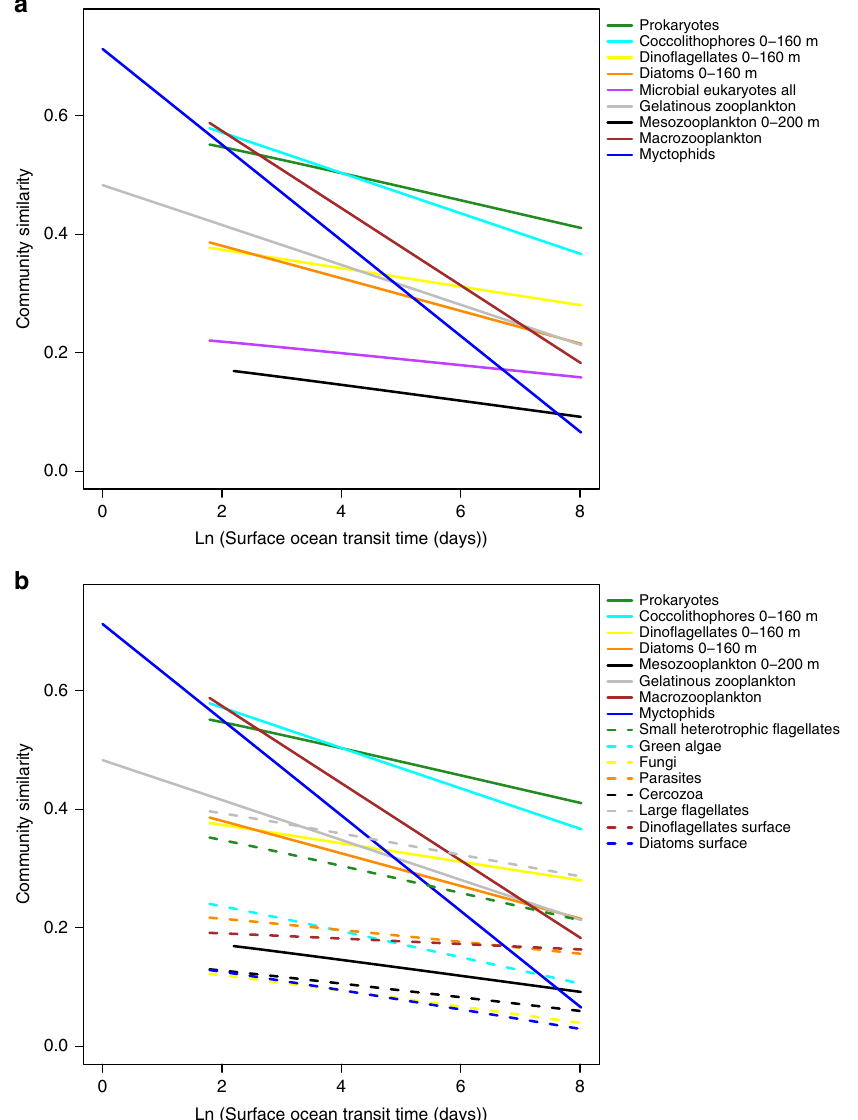
Fig. 1 Time-decay between community similarity and surface ocean transit time. Time-decay relationship between community similarity using Jaccard similarity index and surface ocean transit time. Each line represents the community similarity decay between the species similarity and the logarithm of the surface ocean transit times for each biological group. a Main biological groups: prokaryotes (green); coccolithophores 0 – 160 m (cyan); dino fl agellates 0 – 160 m (yellow); diatoms 0 – 160 m (orange); microbial eukaryotes all (purple); gelatinous zooplankton (gray); mesozooplankton 0 – 200 m (black); macrozooplankton (brown); myctophids (blue). b All biological groups: prokaryotes (solid green); coccolithophores 0 – 160 m (solid cyan); dino fl agellates 0 – 160 m (solid yellow); diatoms 0 – 160 m (solid orange); mesozooplankton 0 – 200 m (solid black); gelatinous zooplankton (solid gray); macrozooplankton (solid brown); myctophids (solid blue); small heterotrophic fl agellates (dashed green); green algae (dashed cyan); fungi (dashed yellow); parasites (dashed orange); cercozoa (dashed black); large fl agellates (dashed gray); dino fl agellates surface (dashed brown); diatoms surface (dashed